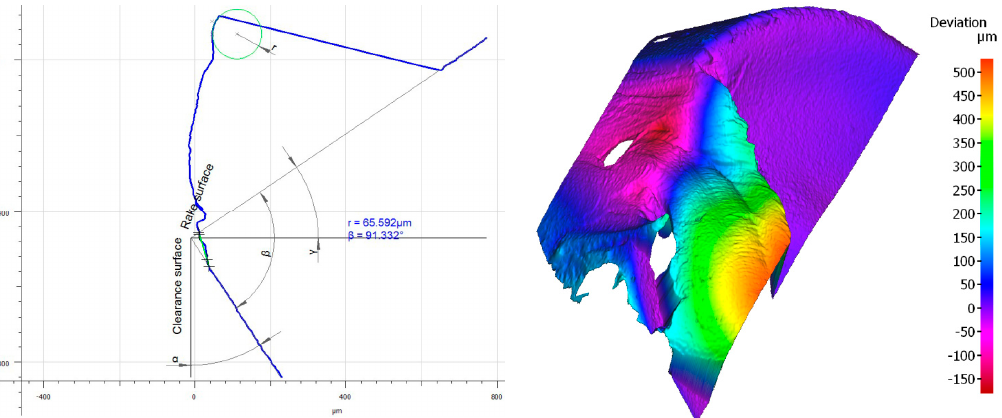
Figure 12. Topography and cross section profile of the cutting edge of a worn cutting insert with the S05F coating after 19 min of machining.